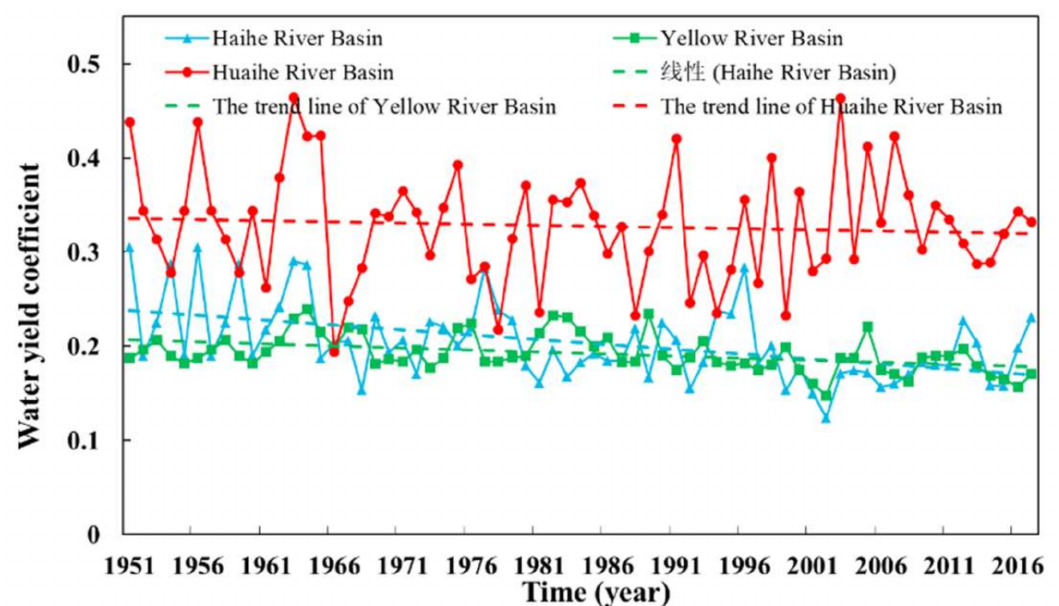
Figure 3. Water yield coefficients for the three first-level regions in the Huang-Huai-Hai River Basin during 1951–2017.